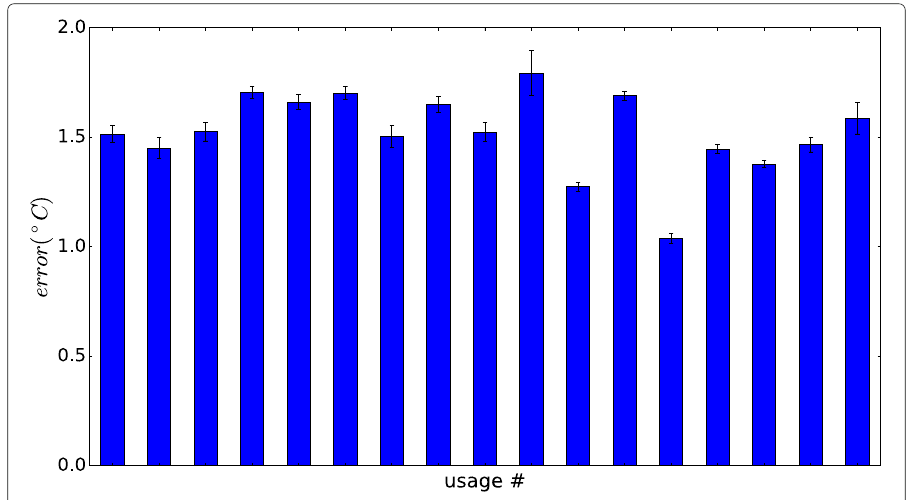
Fig. 3 Simulation Error. ThermalSim can simulate daily room temperature with an RMSE of 1.52 ◦ C (σ = 0.18 ◦ C